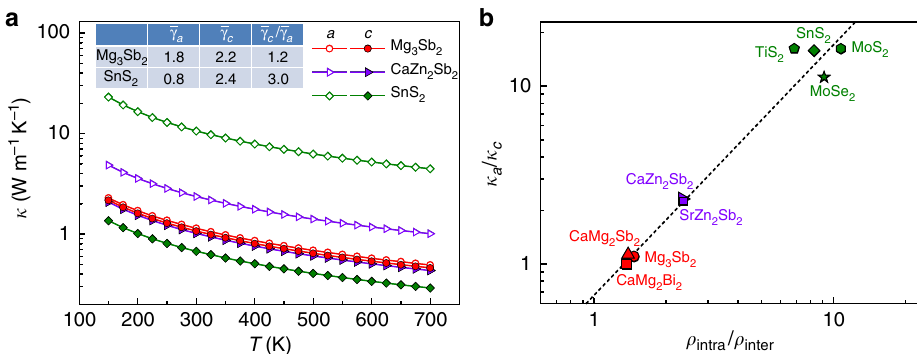
Fig. 5 Lattice thermal conductivity. a Calculated lattice thermal conductivity of Mg 3 Sb 2 , CaZn 2 Sb 2 , and SnS 2 along a and c directions as a function of temperature. The inset table displays the average Grüneisen parameters at room temperature along a and c directions. b Anisotropy of lattice thermal conductivity κ a / κ c at 300 K as a function of the intralayer-to-interlayer bond-strength ratio ρ intra / ρ inter . ρ intra and ρ inter represent the electron density values at BCPs of the intralayer and interlayer bonds, respectively. The theoretical lattice thermal conductivity data of MoSe 2 and MoS 2 are adapted from ref. 3 . The dashed line is a guide to the